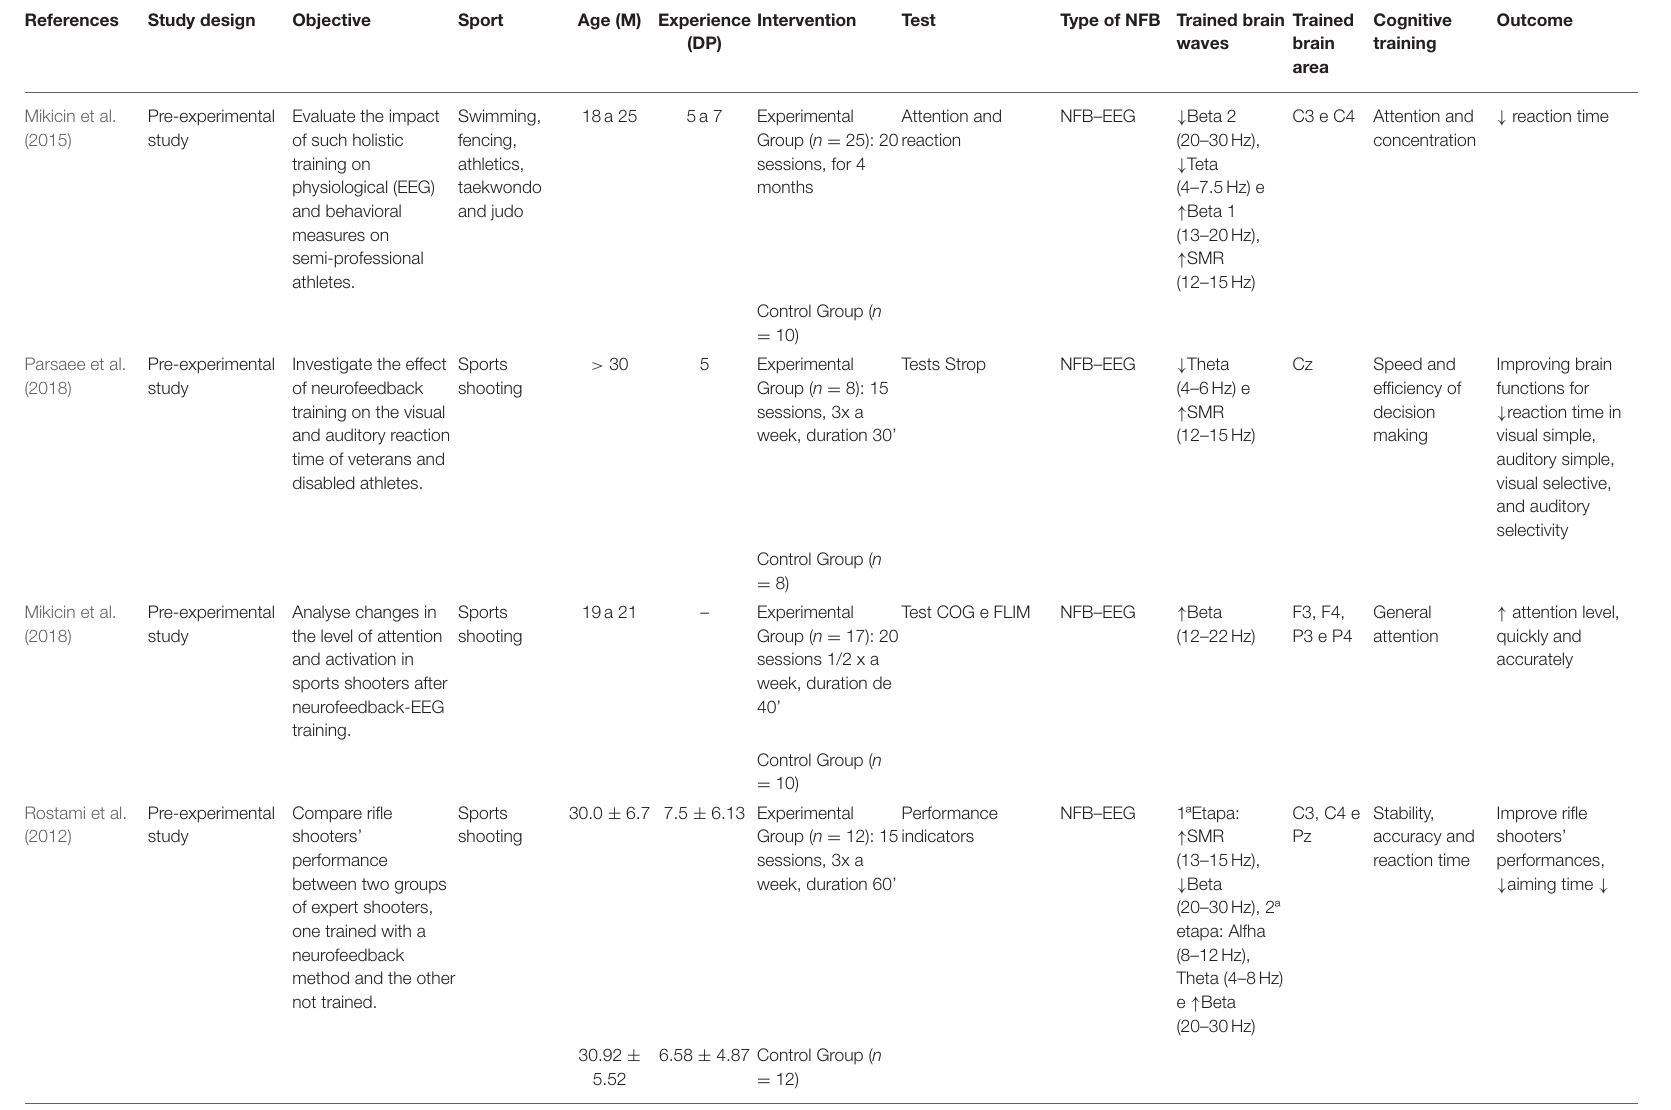
TABLE 3 | Characteristics of the studies included in the meta-analysis-reaction time and